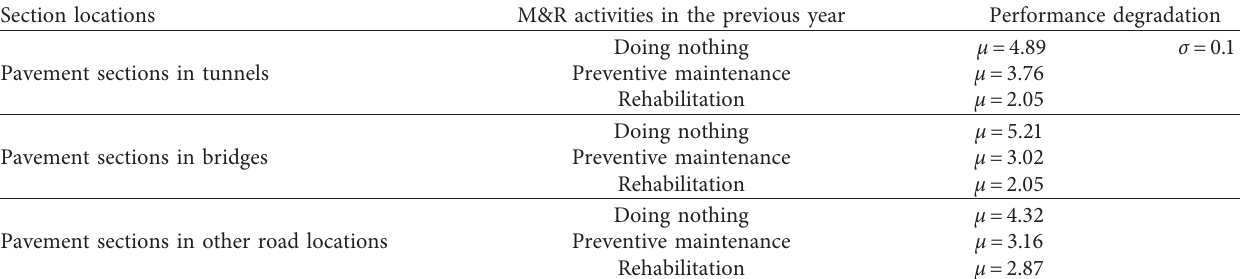
Table 3: Normal distribution parameters of performance degradation in different